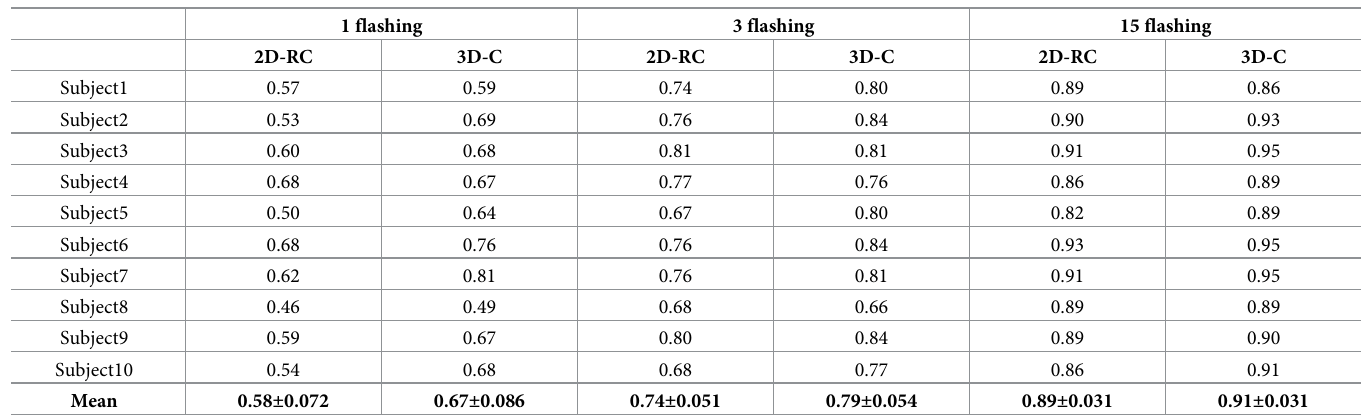
Table 1. ACRC values of radar plots for Figs 13 and 14.